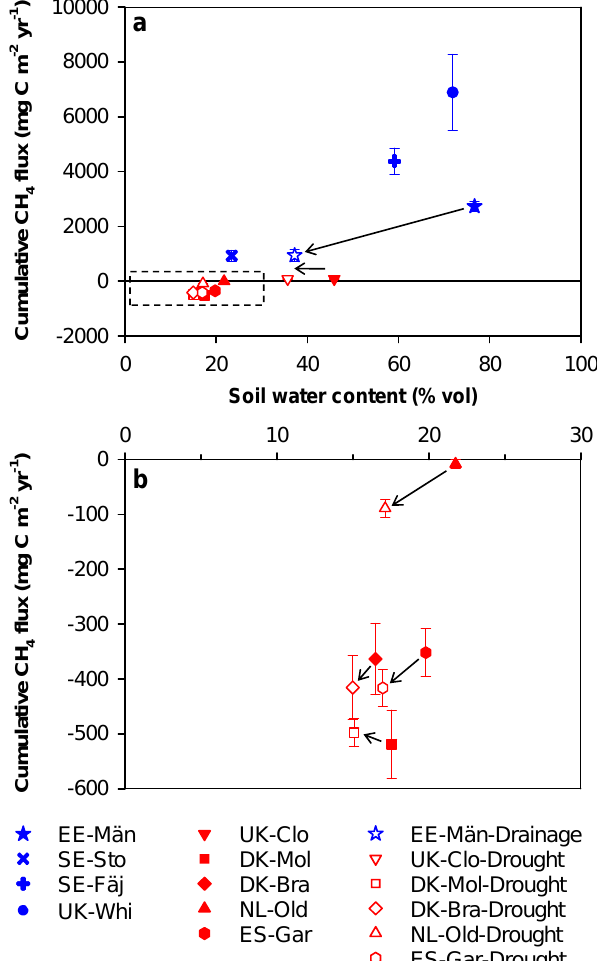
Fig. 4. Annual CH 4 flux at the nine sites related to mean annual soil water content, predominantly measured in the top 10cm soil layer (means ± SE). Closed symbols are control plots, whereas open sym- bols are drained or drought treated plots. Arrows indicate direction of treatment responses. In (b) , the bottom left corner of (a) has been enlarged. Site codes are described in Table